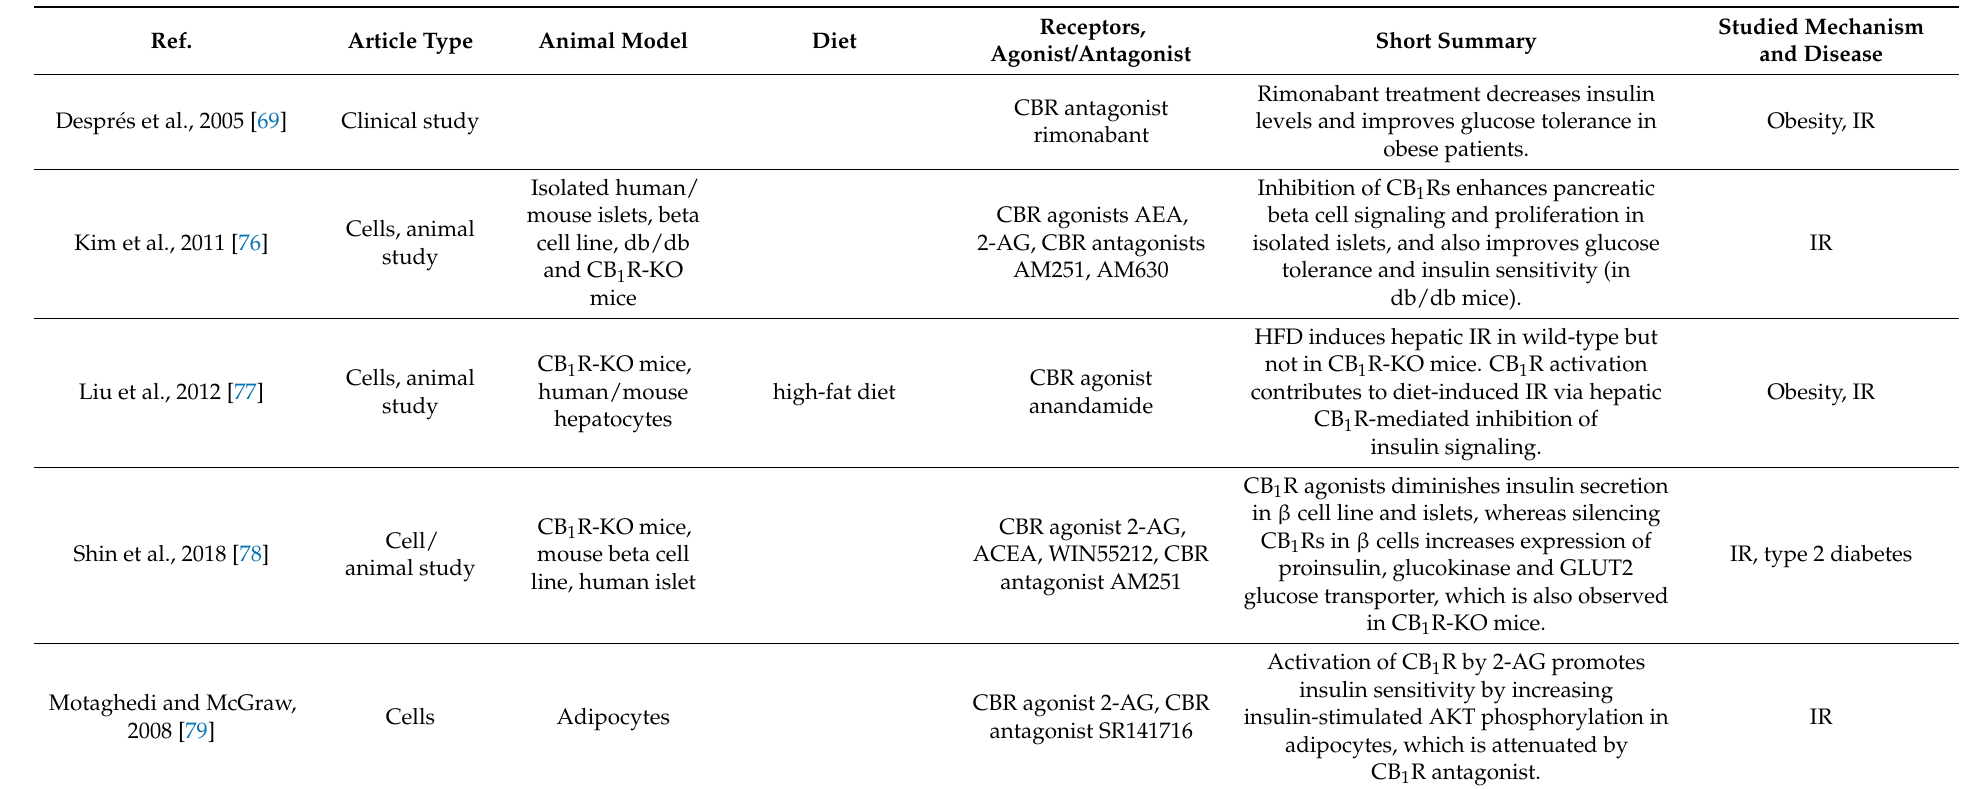
Table 2. Effects of endocannabinoid system and cannabinoids on carbohydrate and lipid metabolism and a relationship with insulin resistance and type 2 diabetes mellitus. Analysis from references. Original and review articles discussing CB receptor-dependent methods (KO mice, agonists, antagonists) are emphasized. CBR, cannabinoid receptors, CB 1 R and CB 2 R, cannabinoid receptors type 1 and 2, KO, knockout, 2-AG, 2-arachidonoylglycerol, THC, tetrahydrocannabinol, AEA,